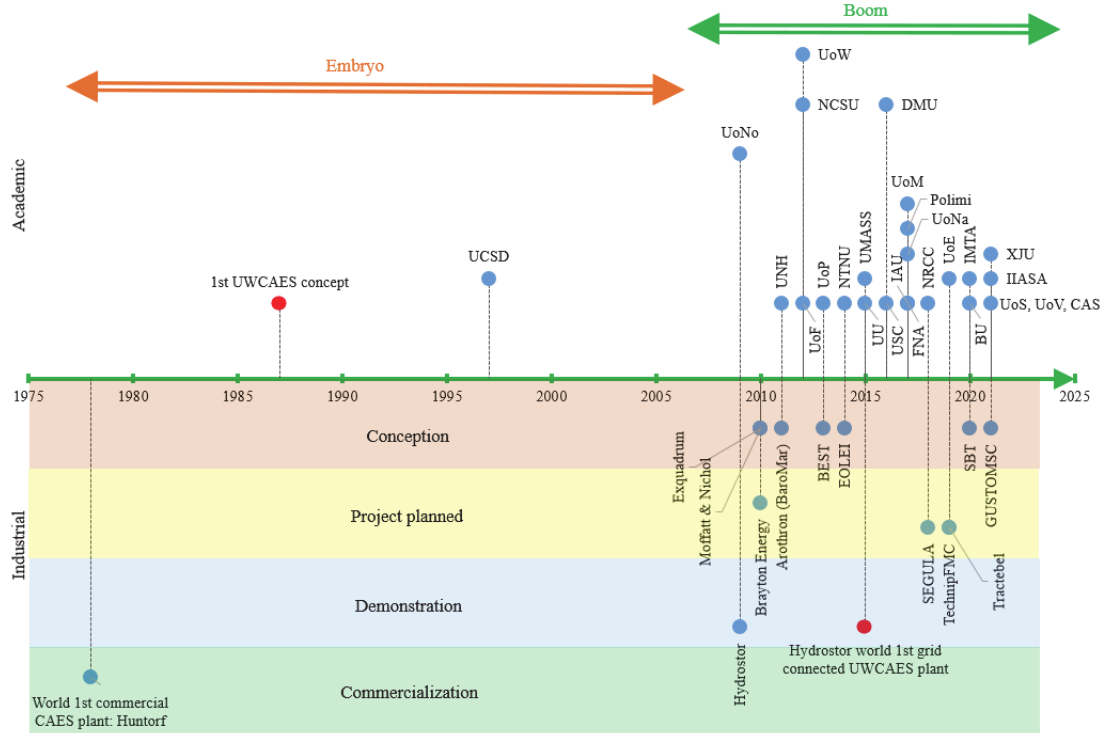
Figure 1. Schematic diagrams of UWCAES: ( a ) UWCAES with adiabatic compression and expan ‐ sion; ( b ) UWCAES with isothermal compression and expansion.